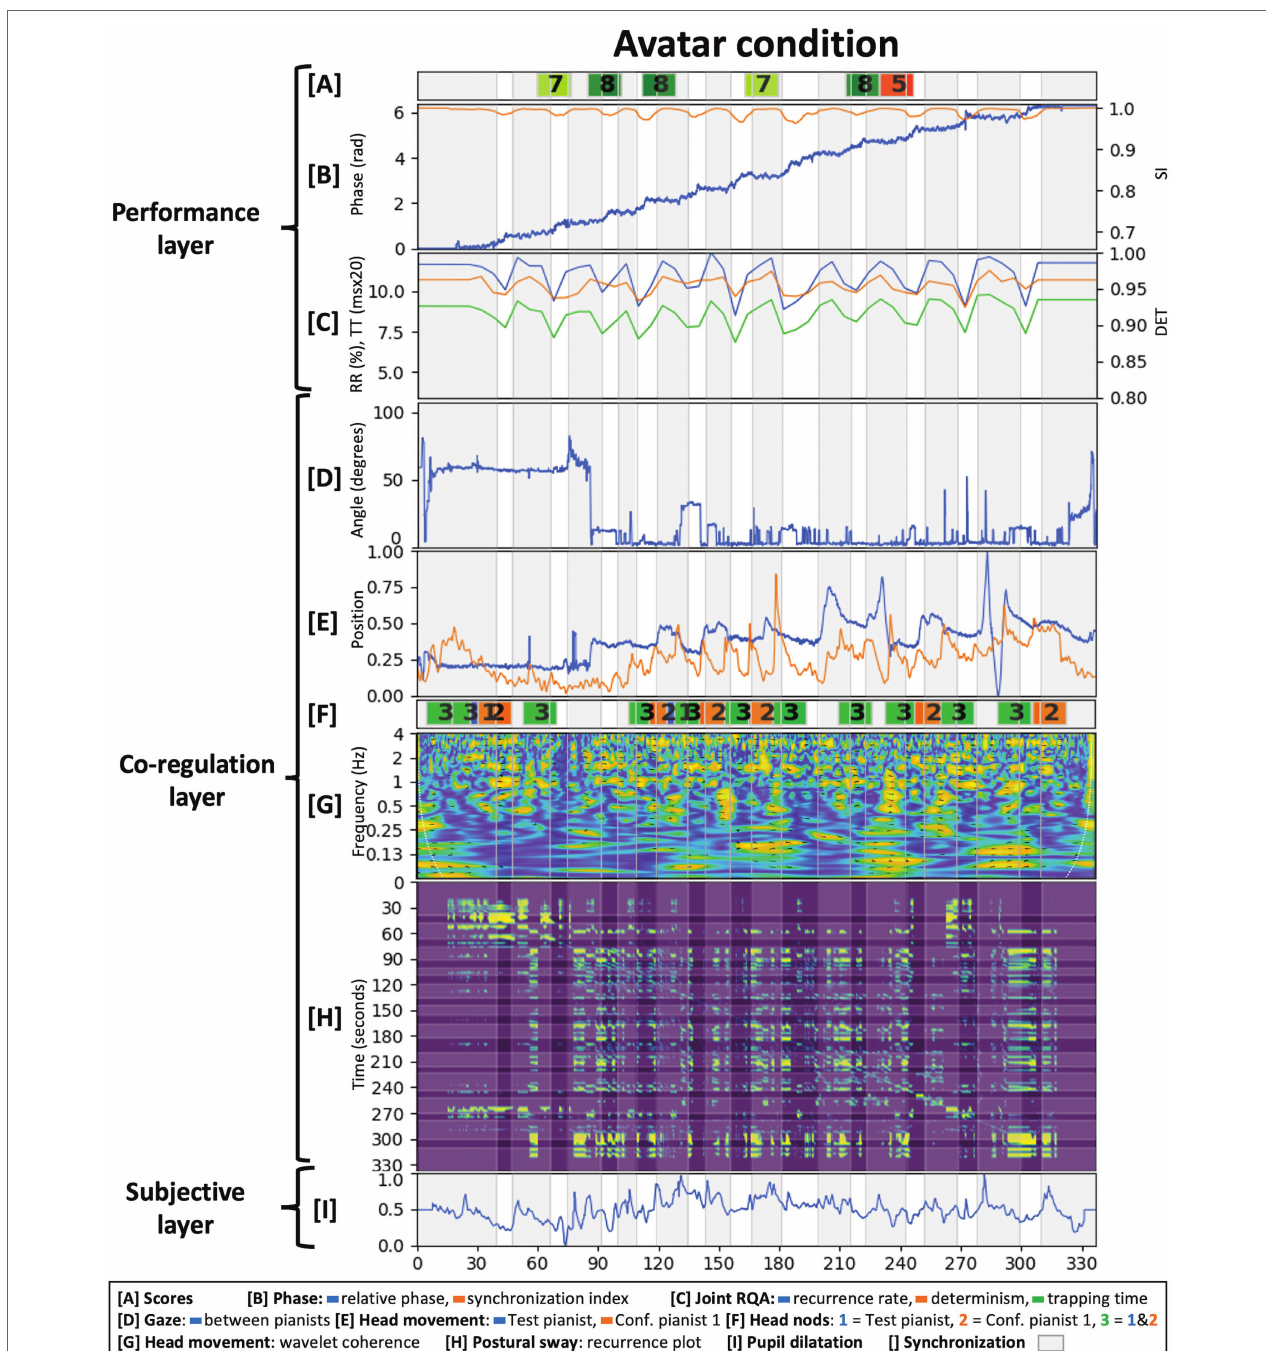
FIGURE 7 | Analysis of the avatar condition across the three interrelated layers from the proposed methodological